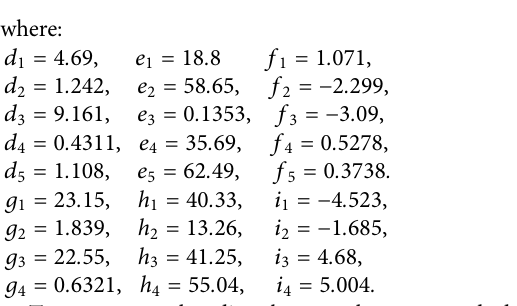
FIGURE 7 | Curve- fi tted and scaled data of hip acceleration. In the fi gures, A — Curve- fi tted data (without scaling), B — Experimental data from Winter (2009), C — Curve- fi tted data with 70% amplitude scaling, D — Curve- fi tted data with 85% frequency scaling, and E — Curve- fi tted data with 80% amplitude and 85% frequency